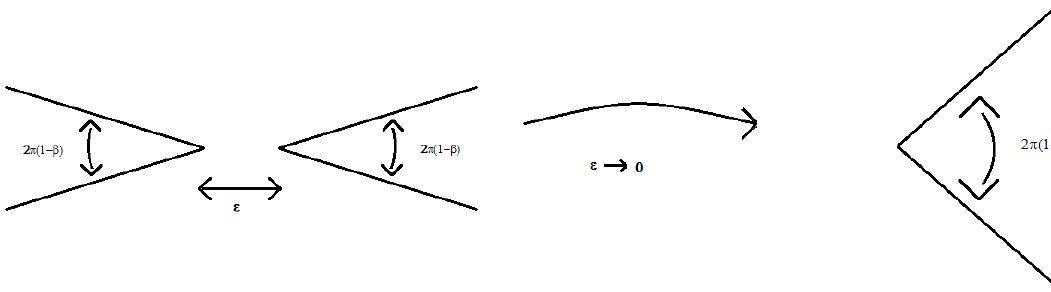
Fig. 1. 1 (cid:0) (cid:13) D 2.1 (cid:0) ˇ/ . When two cone singularities collide the complements of the angles